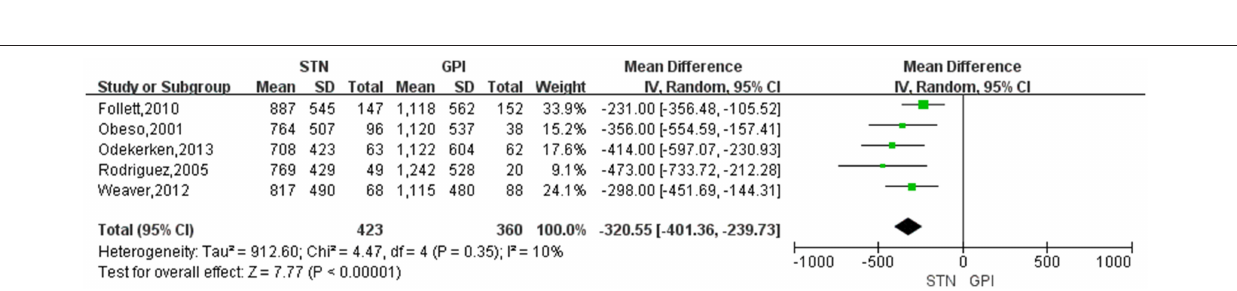
FIGURE 5 | Forest plot of standardized mean difference of levodopa equivalent doses between STN DBS and GPi DBS. GPi, globus pallidus interna; STN, subthalamic nucleus; IV, inverse variance; CI, confidence interval.